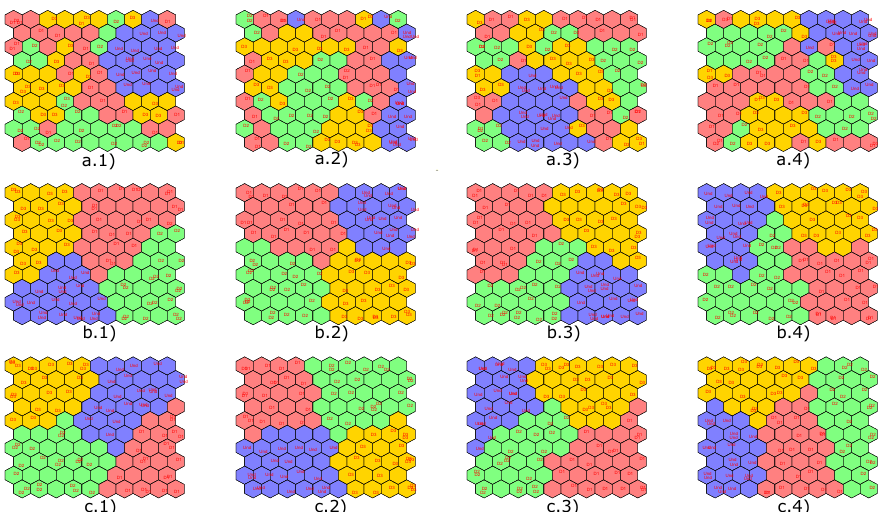
Figure 22. Results obtained by implementing the CPANN ( a ), SKN ( b ) and XYF ( c ) networks for: 2 principal components (group 1), 4 principal components (group 2), 6 principal components (group 3) and 8 principal components (group